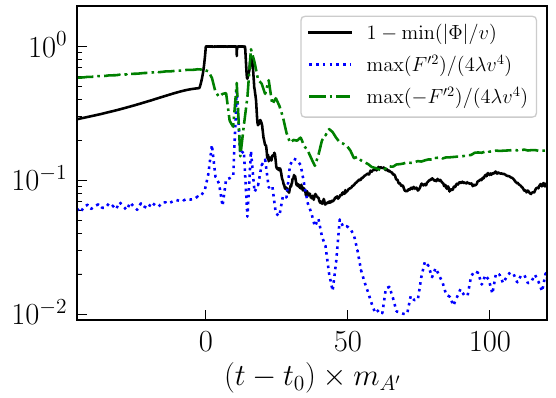
Figure 12 . Similar to figure 4, but for a dark photon cloud that arises through superradiance around a spinning black hole. This is the case with dimensionless black hole spin χ BH = 0 . 99 , α ≡ GM BH m A 0 = 0 . 4 , and λ/g 2 = 25 from [33]. We show the displacement from the VEV of the D minimum scalar field magnitude (solid black line) around the time when vortices form at t = t 0 . The vortices persist for ≈ 14 m A 0 and then are absorbed by the black hole. We also show the maximum values of F 0 2 (dotted blue line; corresponding to magnetic dominance) and − F 0 2 (dashed-dotted green line; corresponding to electric